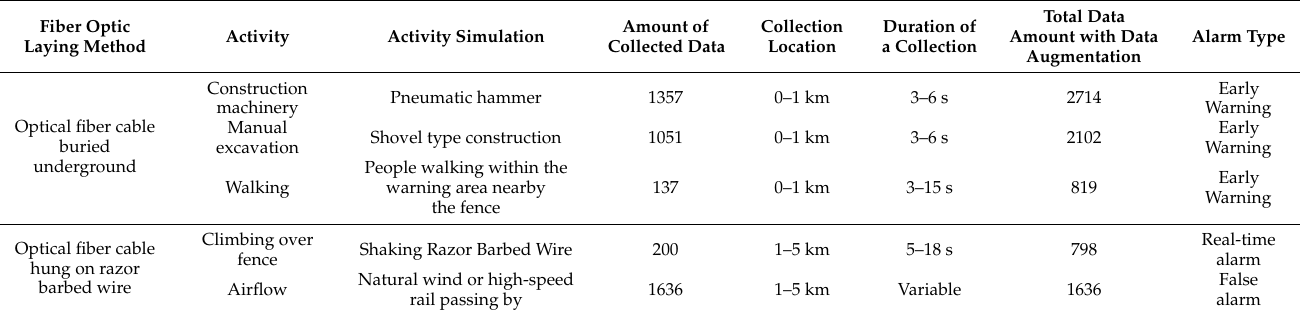
Table 1. Distribution of each vibration pattern in the described